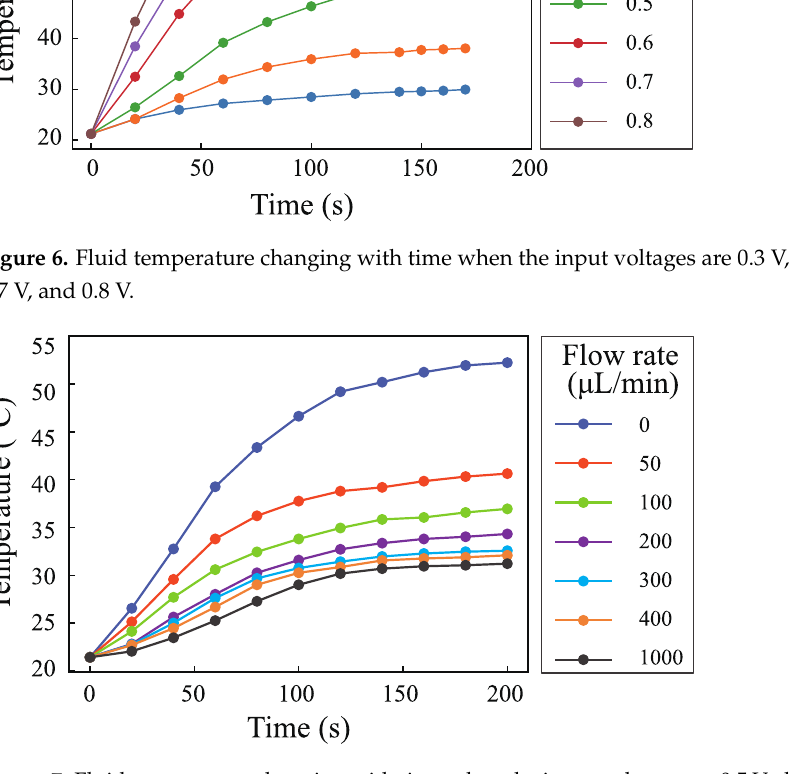
Figure 7. Fluid temperature changing with time when the input voltage was 0.5 V; the flow rates were 0 µ L min − 1 , 50 µ L min − 1 , 100 µ L min − 1 , 200 µ L min − 1 , 300 µ L min − 1 , 400 µ L min − 1 , and · · · · · · 1000 µ L min − 1 . ·